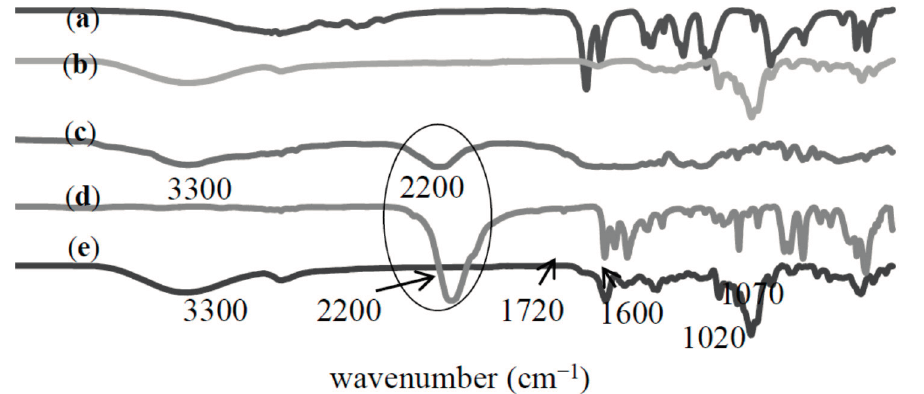
Figure 2. FTIR spectra of (a) methacrylic acid (MAA); (b) β -cyclodextrin ( β -CD); (c) methacrylic acid bonded toluene-2,4-diisocyanate (MAA-TDI); (d) toluene-2,4-diisocyanate (TDI); (e) methacrylic acid functionalized β -cyclodextrin (MAA- β -CD).